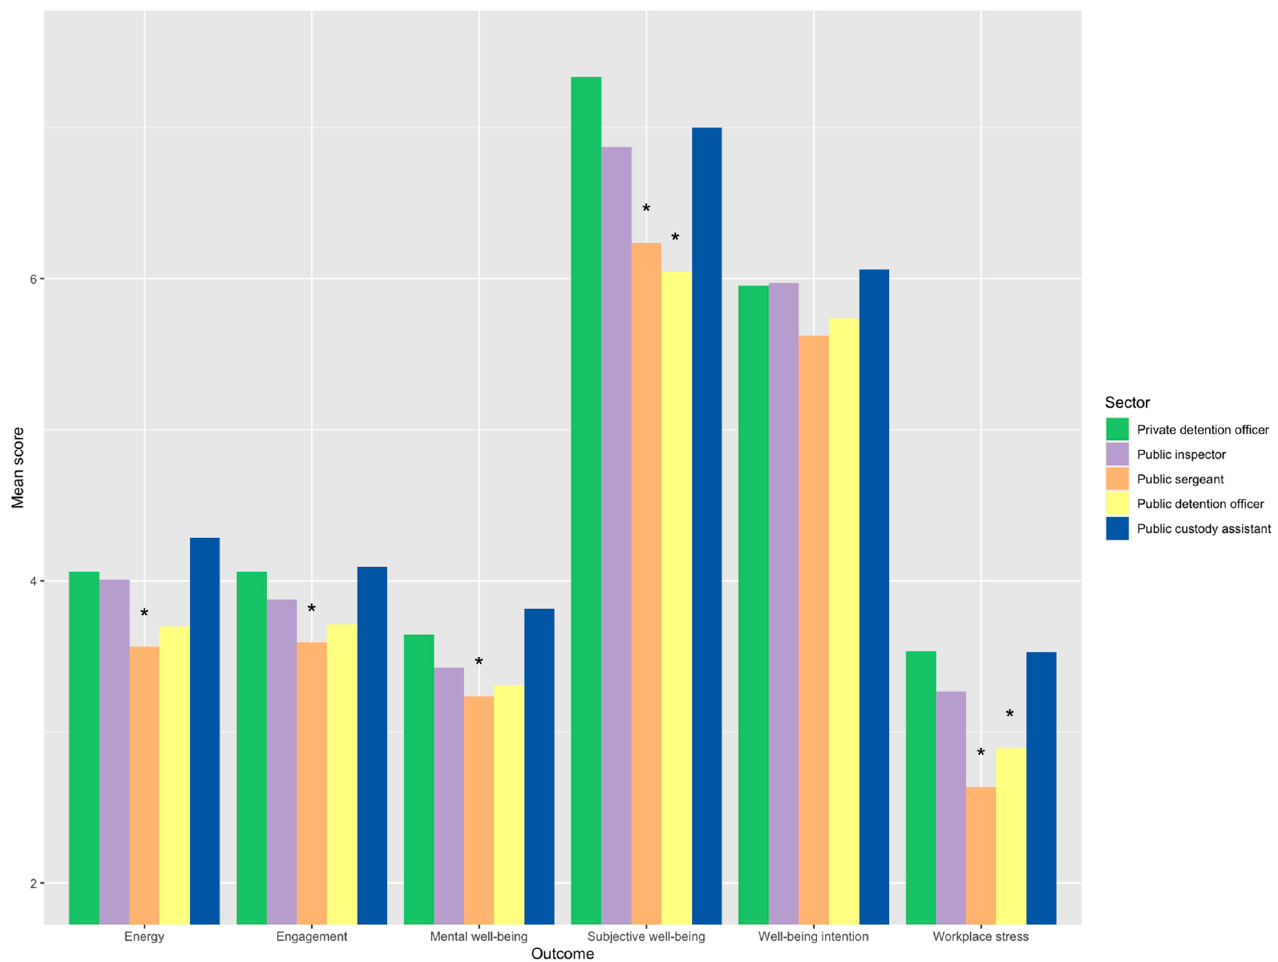
Figure 2. Clustered bar of mean scores for well-being outcome by sector and role with statistically significant differences indicated by *.